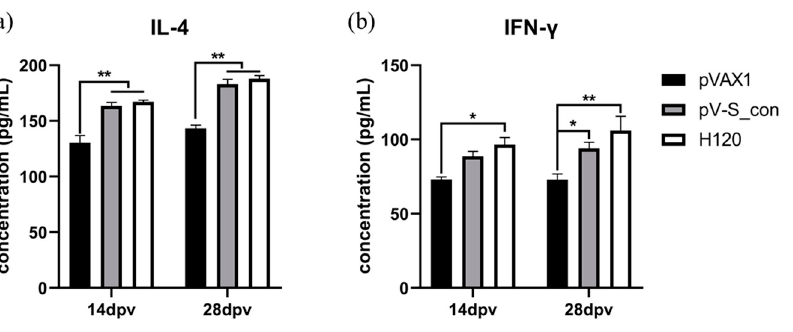
Figure 6. Analysis of the IL-4 ( a ) and IFN- γ ( b ) concentrations in the serum on the 14th and 28th dpv. Tukey’s multiple comparison test was used for statistical analysis. Concentrations are shown as mean values + SEM of each group; * p < 0.05, ** p < 0.01.